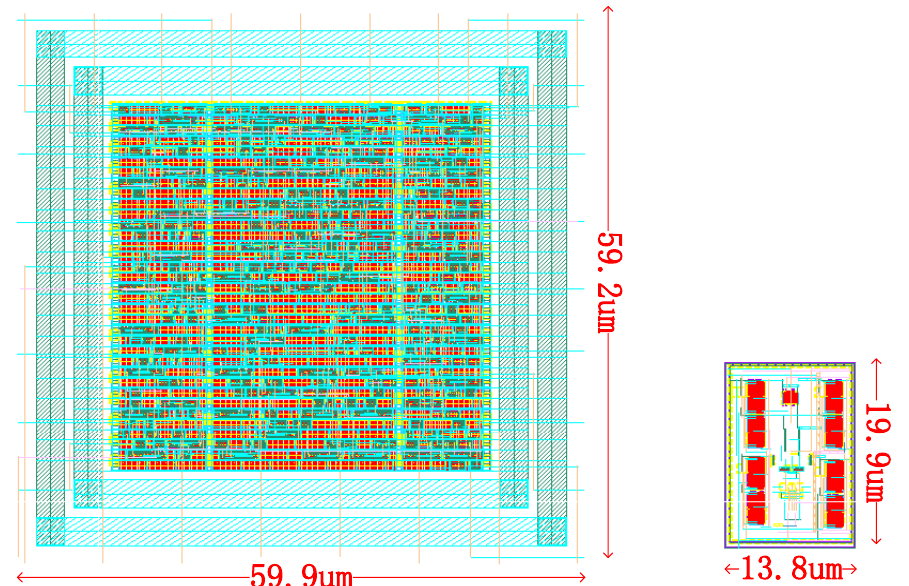
Figure 9. Layout view of a single CMOS-based stochastic Ising spin (left) and a single MTJ-based E-spin (right). The layout of the CMOS-based stochastic Ising spin is automatically generated by EDA (electronic design automation) software DC (Design Compiler) and ICC (IC Compiler). The layout of the MTJ-based E-spin is a customized design using Virtuoso.